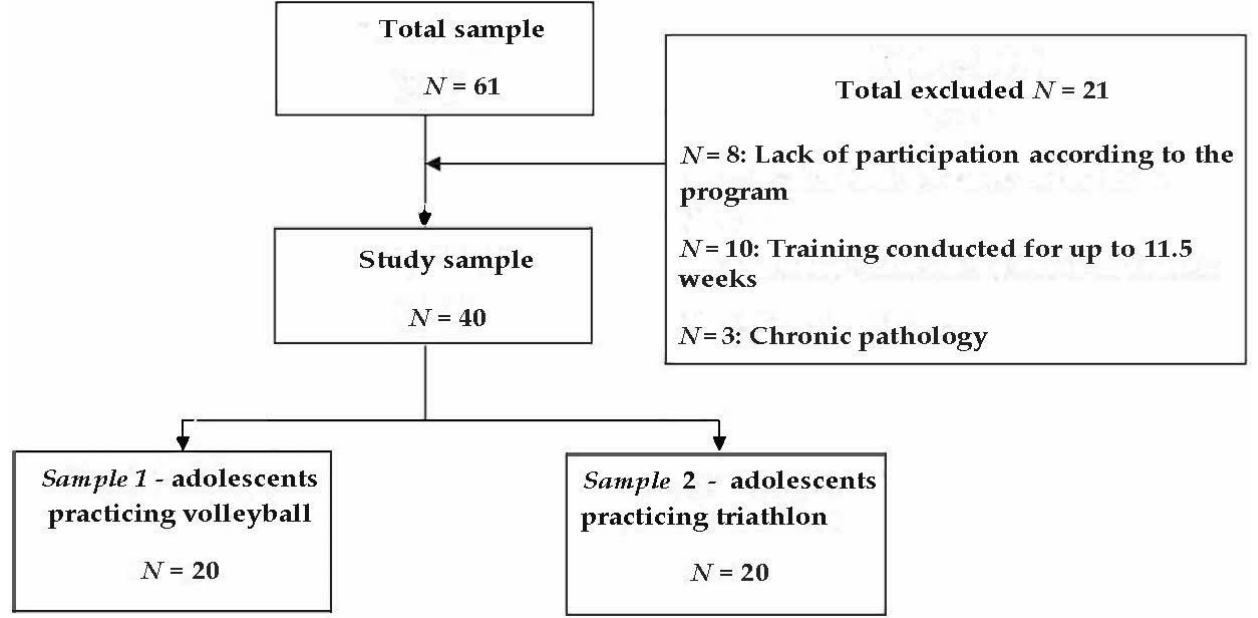
Figure 1. Flowchart of the study sample.